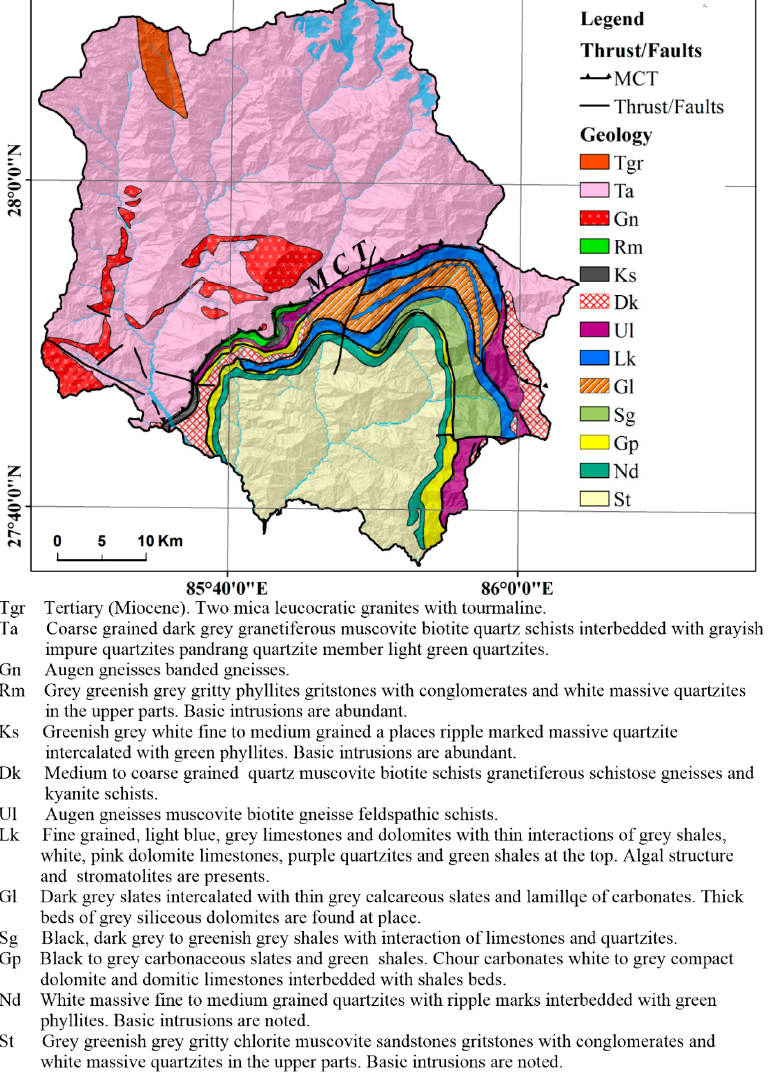
Figure 6. Geological map of the study area (Modified from Dhital 2015).